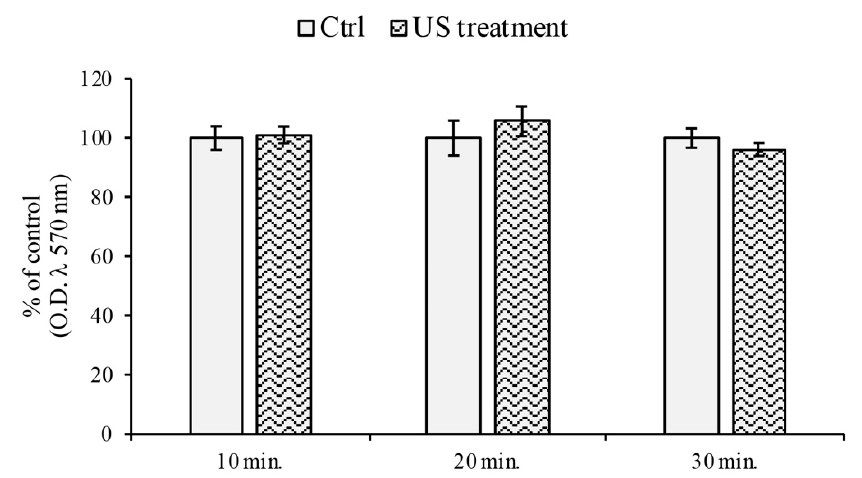
Figure 2. Cell viability (MTT) assay on RBE4 cells during US stimulation. The RBE4 cell line was stimulated with US for 10, 20, and 30 min. As reported, the cell viability did not significantly change during treatment in comparison to those in the control (untreated cells), arbitrarily taken as 100%. Values are expressed as the mean ± S.E.M. of three independent experiments, performed in quintuplicate.